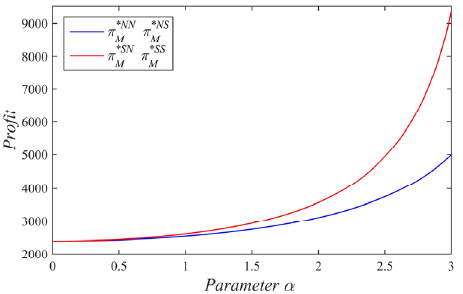
Figure 8. The impact of parameter α on the profits of manufacturer.